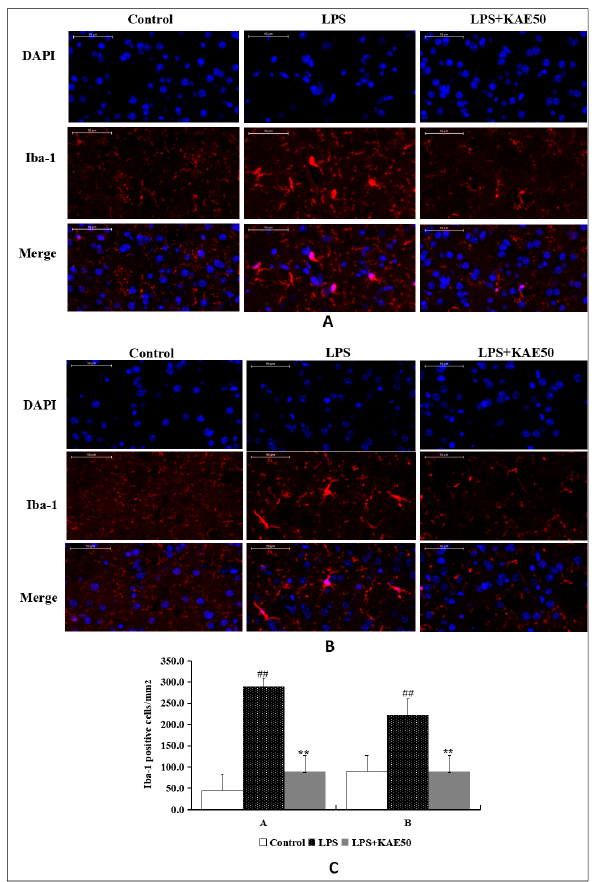
Figure 2. Effect of kaempferol on microglial activation stained by immunohistochemistry with anti ‐ Iba ‐ 1 antibody. ( A ) Representative image in ventral striatum of mice; ( B ) Representative image in dorsal striatum of mice; and, ( C ) The quantitative analysis of Iba ‐ 1 positive cells. Values are mean ±SD ( n = 3). ## p < 0.01 vs. control group. ** p < 0.01 vs. LPS group. Scale bars 50 μ m in ( A and B ).